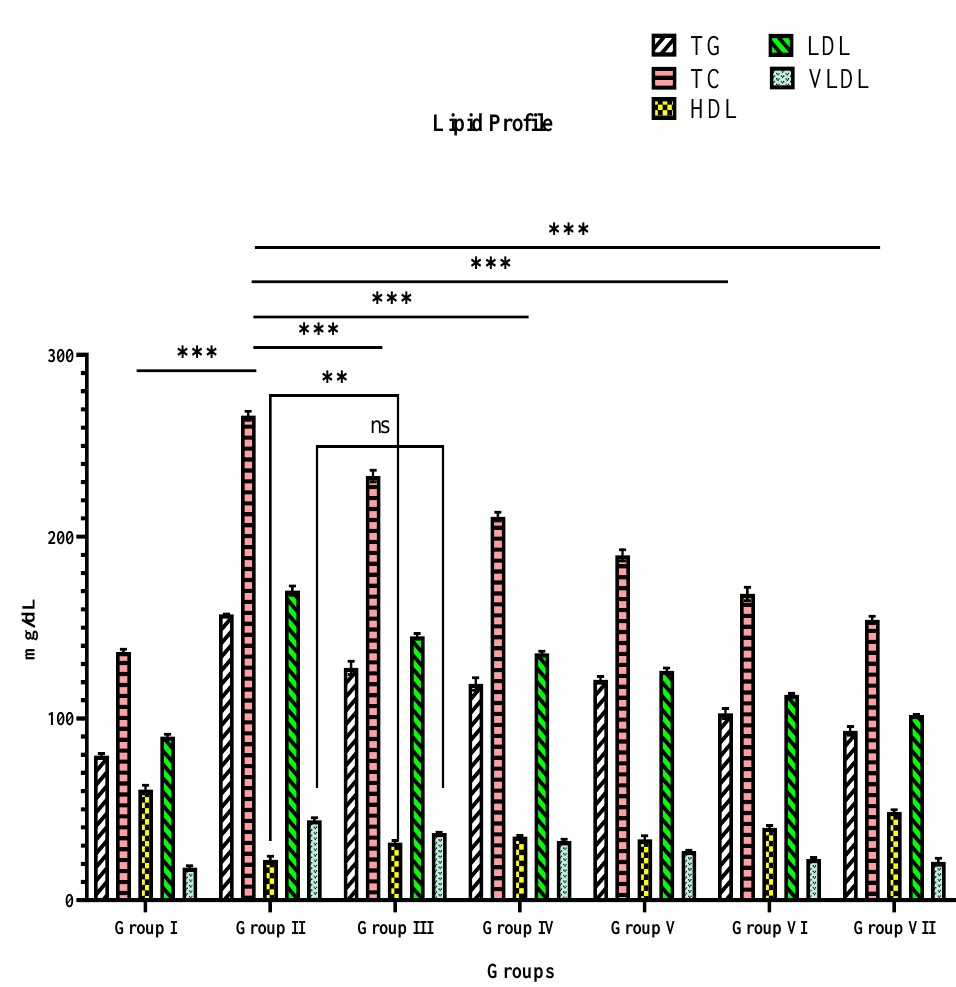
Figure 8. Graphical representation of TPE and TPE-ZnO NPs’ effects on lipidemia (mg/dL) in STZ- induced diabetic rats. Group I: Normal control (0.1% CMC suspension); Group II: Diabetic control (received STZ 55 mg/Kg bw); Group III: TPE (100 mg/Kg bw); Group IV: TPE (200 mg/Kg bw) treatment; Group V: TPE-mediated ZnO NPs (100 mg/Kg bw); Group VI: TPE-mediated ZnO NPs (200 mg/Kg bw); Group VII: Glibenclamide (10 mg/Kg bw). Values are expressed as mean ± SEM, ( n = 6); p < 0.12 (ns), p < 0.002 (**), p < 0.001 (***) compared to diabetic animals/Group II (two-way ANOVA followed by a Dunnett’s t -test). p -values < 0.05 were considered statistically